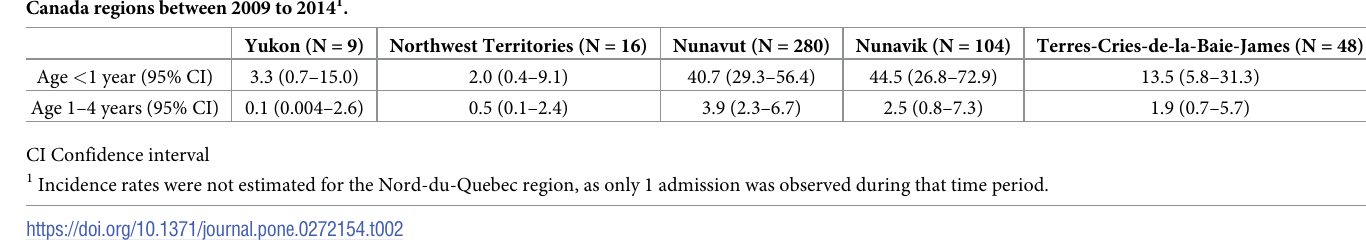
[Table 3]. Regional Northern hospitalization, prior to transfer, varied greatly: the majority of WCH patients arrived directly from nursing stations (n = 179, 92.3%), whereas regional hospi- tals admitted most patients prior to transfer to SCH (n = 81, 91.0%), CHEO (n = 85, 91.4%)